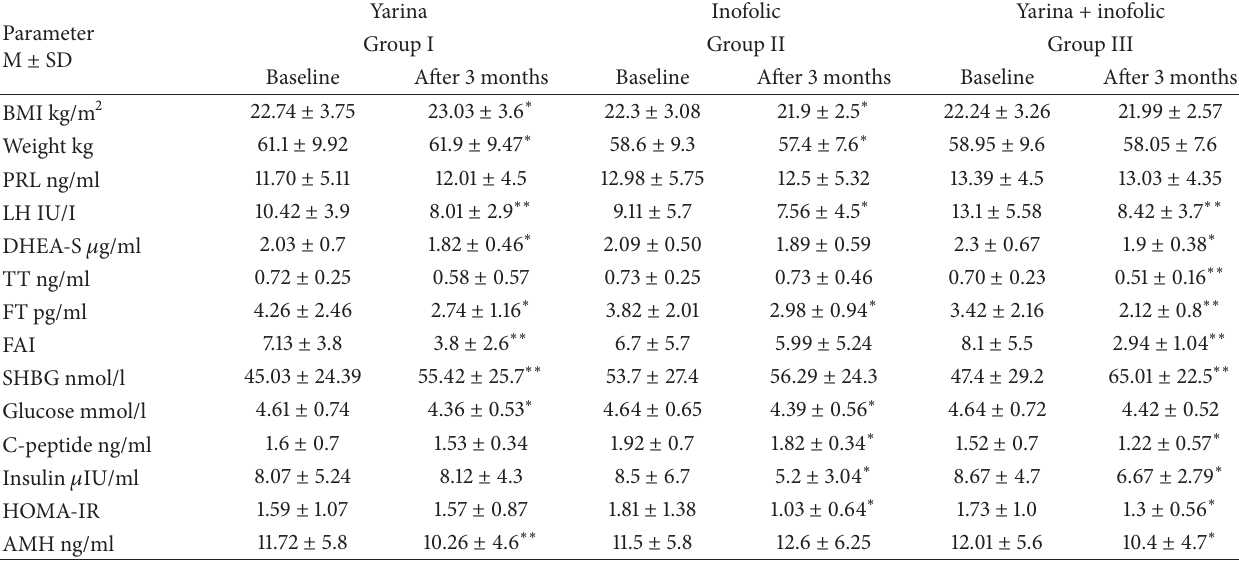
Table 1: Anthropometric, endocrine, and metabolic parameters of the patients in treatment